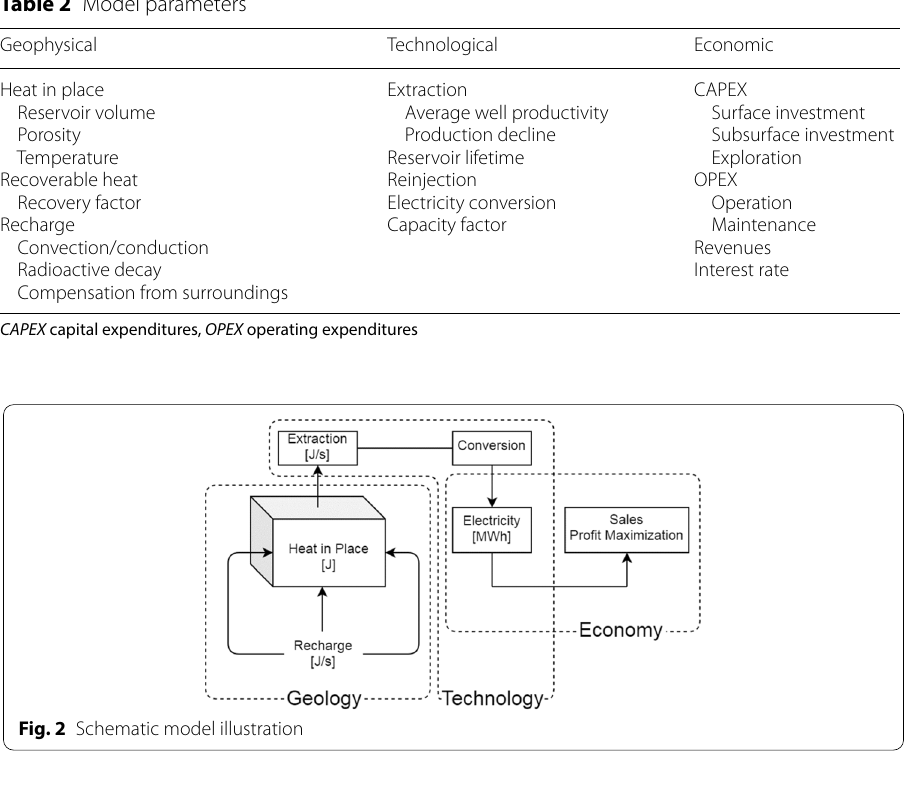
Table 2 Model parameters